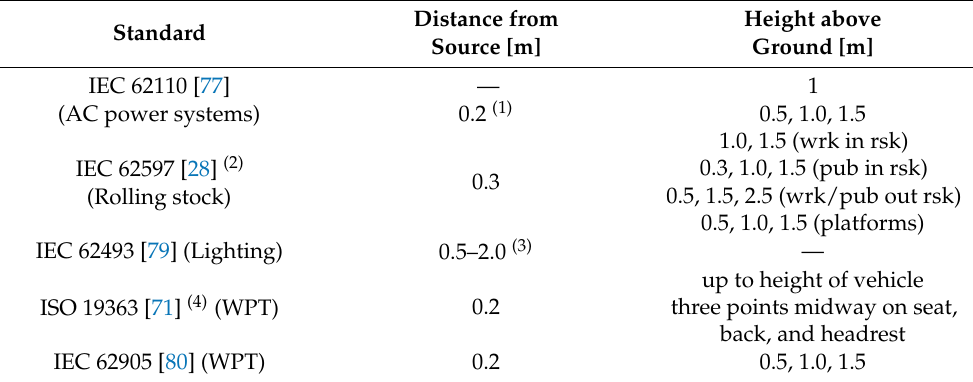
Table 3. Overview of requirements for relative source-person distance and height above